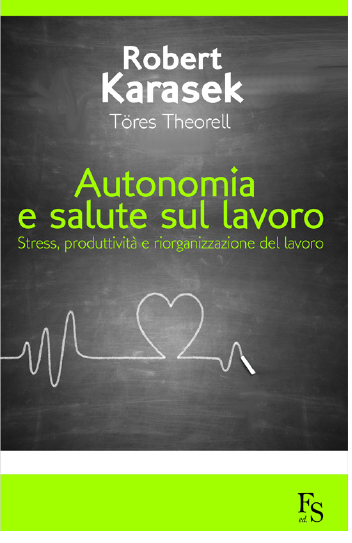
Healthy Work: Stress, productivity and the recon- struction of working